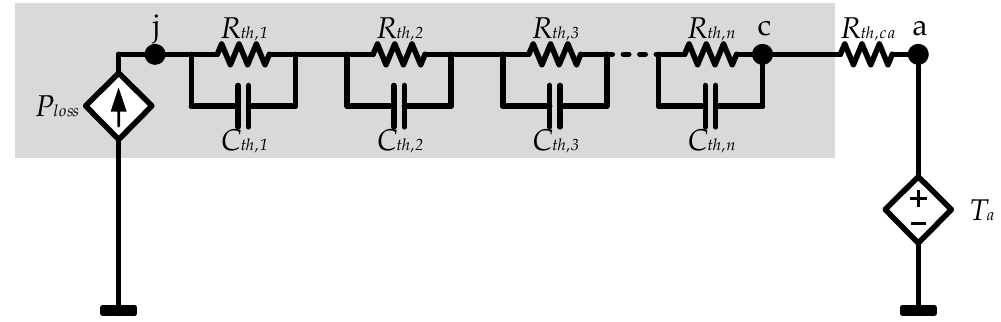
Figure 14. n layer Foster thermal circuit of a semiconductor. From junction temperature to ambient temperature, where the semiconductor is marked by a grey area.